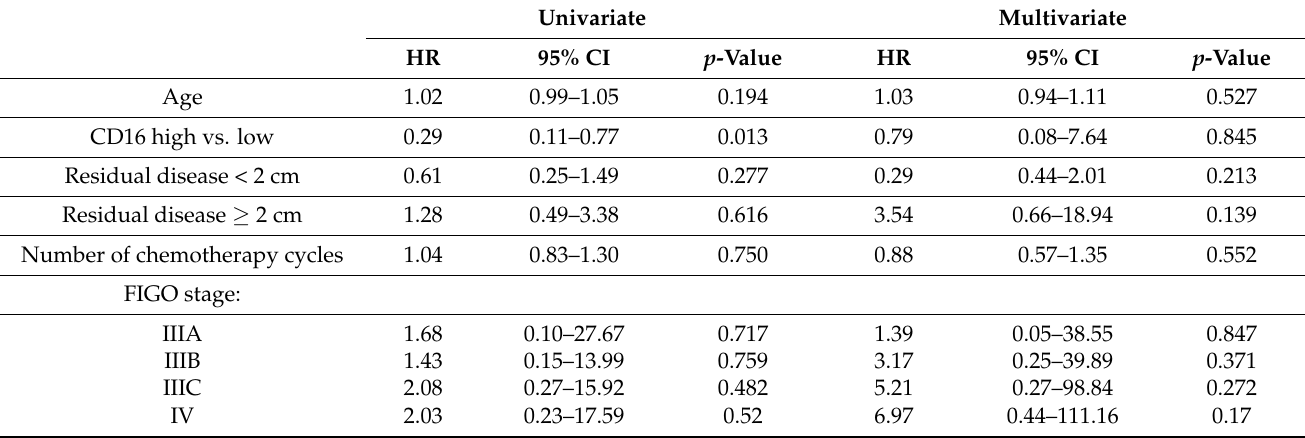
Multivariate analyses showing Hazard ratios and p -value for all recurrent cancer biopsies conferred by categorized CD16 density, age, residual disease after cytoreductive surgery, number of chemotherapy cycles, and FIGO